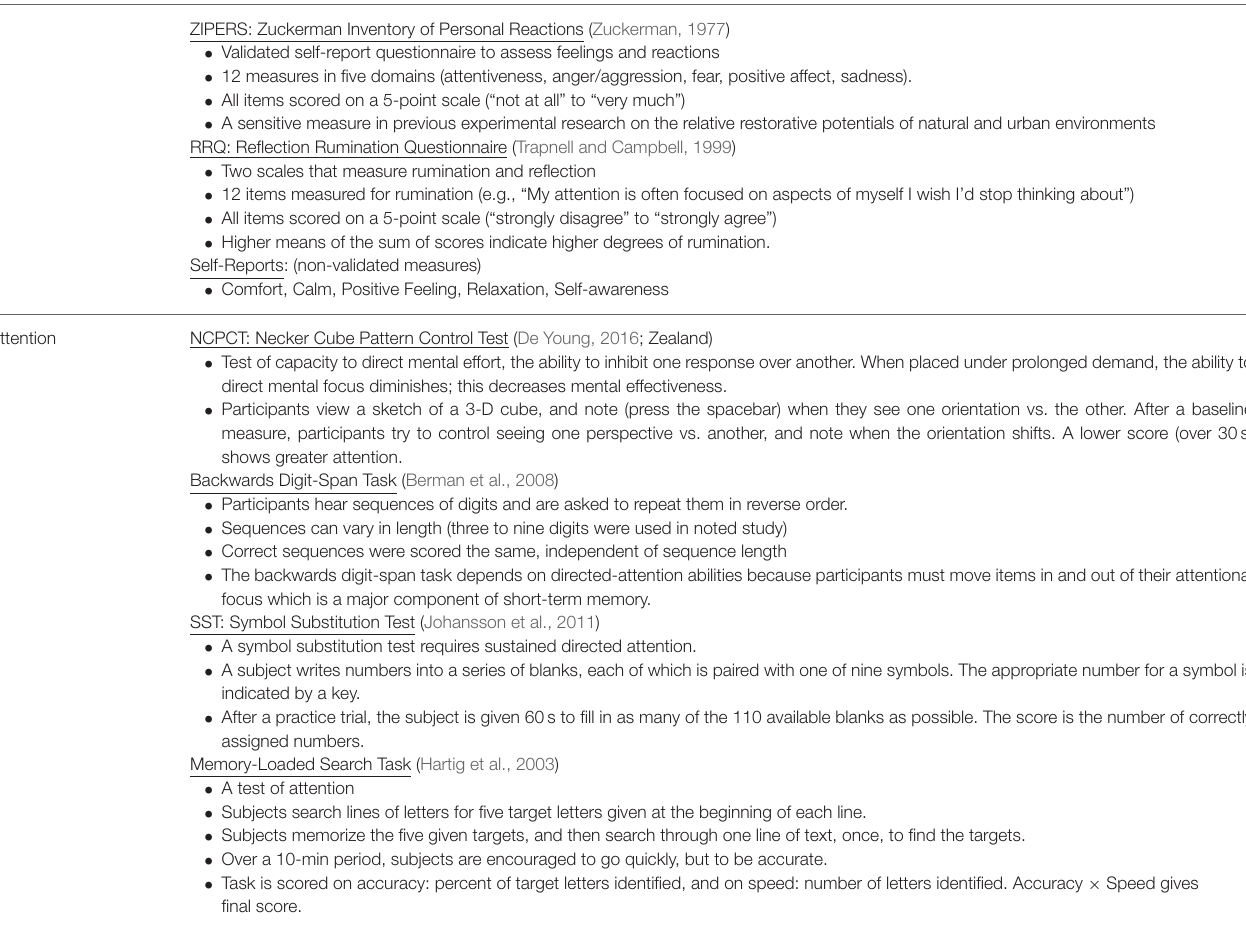
Type of test Test + meaning of test